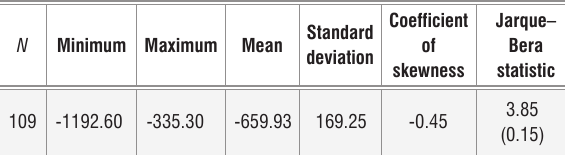
annual rainfall for Zimbabwe from i